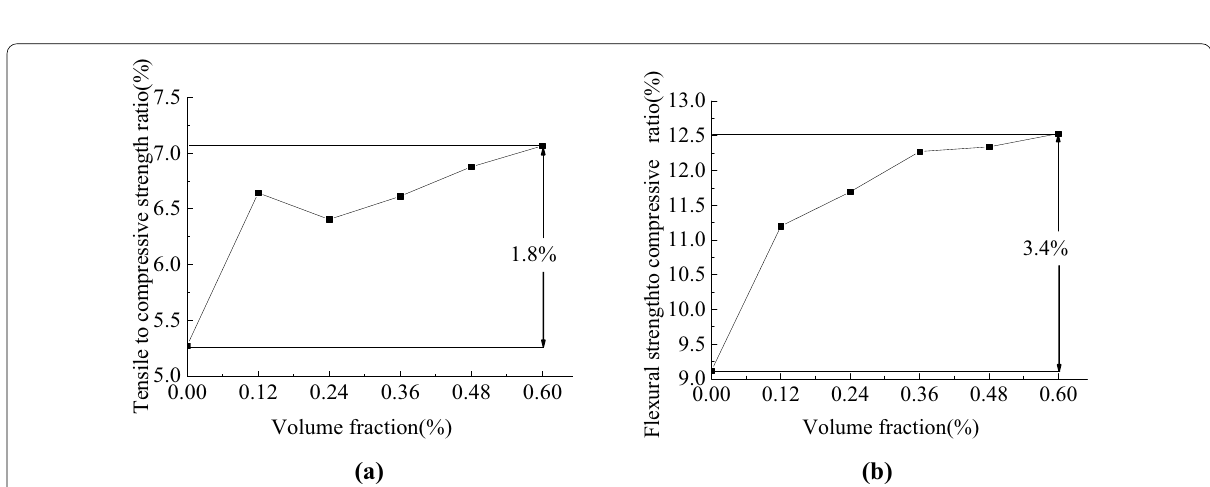
Fig.6 Effect of volume fraction on TC-R and FC-R. (TC-R and FC-R represent the ratios of tensile to compressive strength and flexural to compressive strength,